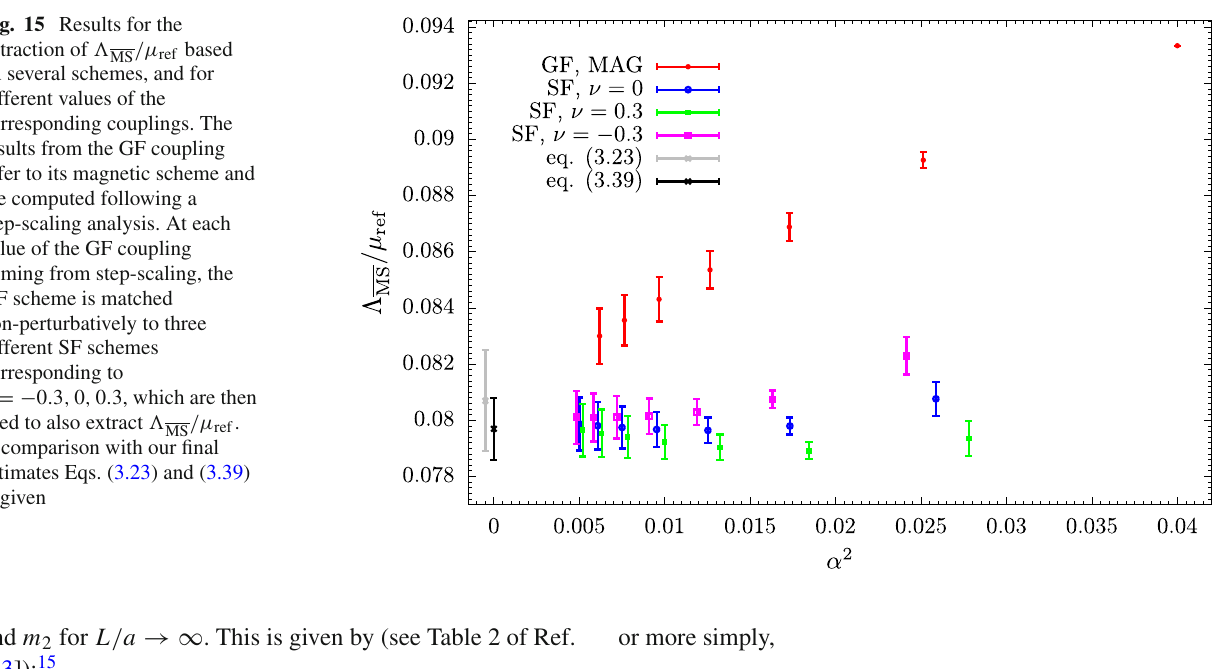
and m 2 for L / a → ∞ . This is given by (see Table 2 of